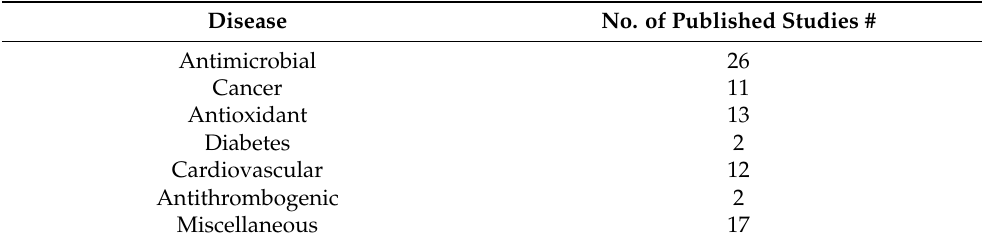
Table 3. Number of published studies per specific disease or pharmacological area. Disease No. of Published Studies #